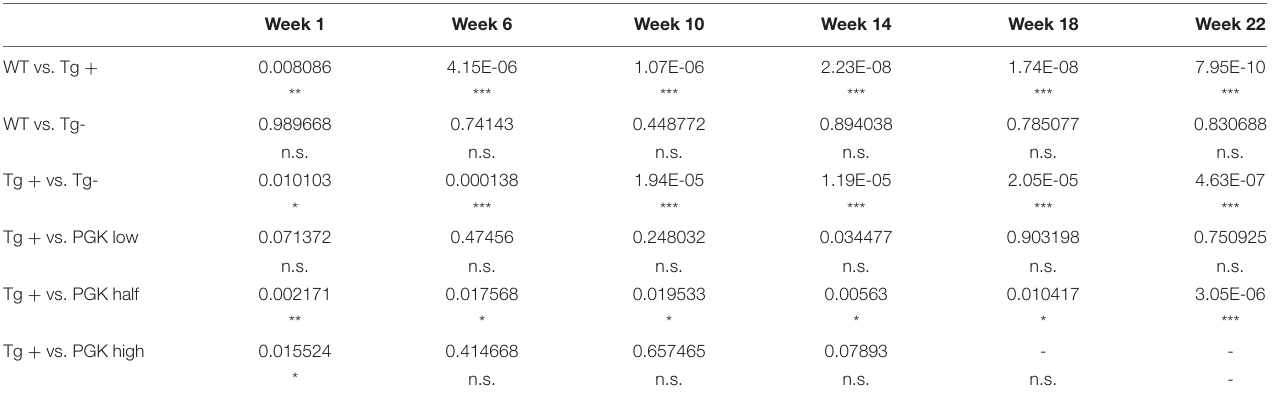
FIGURE 11 | AAV8-mFXN gene therapy restores VGLUT1 expression in the cerebellum of FRDAkd mice. (A) western blot analysis and (B) quantification of VGLUT1 and VGLUT2 levels in AAV8-mFXN treated mice and controls (Stats: mean ± SEM, Two-way ANOVA with Tukey’s post hoc , ∗ P < 0.05). Correlation plots comparing relative frataxin (FXN) levels with relative (C) VGLUT1 and (D) VGLUT2 levels in mice of all treatment groups (Stats: linear regression; frataxin vs. VGLUT1, R 2 = 0.42, P = 0.016; linear regression; frataxin vs. VGLUT2, R 2 = 0.29, P = 0.055; Spearman rank correlation; frataxin vs. VGLUT1, R S = 0.015; Spearman rank correlation; frataxin vs. VGLUT2, R = 0.032). TABLE 3 | P values obtained from a two-way ANOVA on animal weight ( Figure 9C